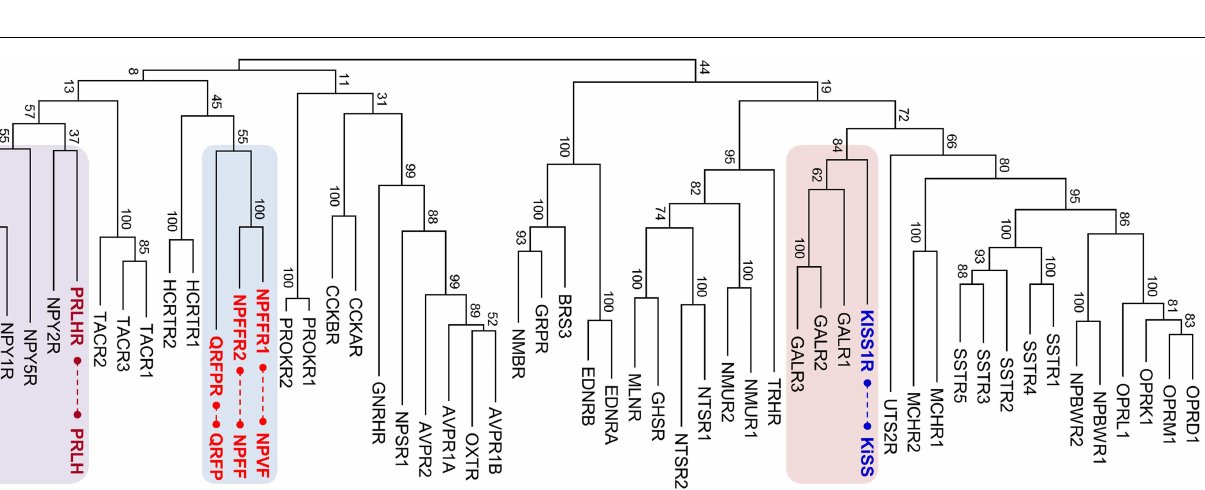
FIGURE 1 | Maximum likelihood phylogenetic tree for human rhodopsin-like neuropeptide GPCRs .The amino acid sequences of the receptors were aligned using MUSCLE, and the tree was constructed by MEGA 5.1.The RF-amide peptide receptor groups are indicated with colored boxes and corresponding peptides are connected by dashed lines. Bootstrap values represent 100 replicates. MLNR, motilin receptor; GHSR, ghrelin receptor; NTSR, neurotensin receptor; NMUR, neuromedin U repceptor;TRHR, thyrotropin-releasing hormone receptor; NMBR, neuromedin B receptor; GRPR, gastrin-releasing peptide receptor; BRS, bombesin receptor; EDNR, endothelin receptor; PRLHR,